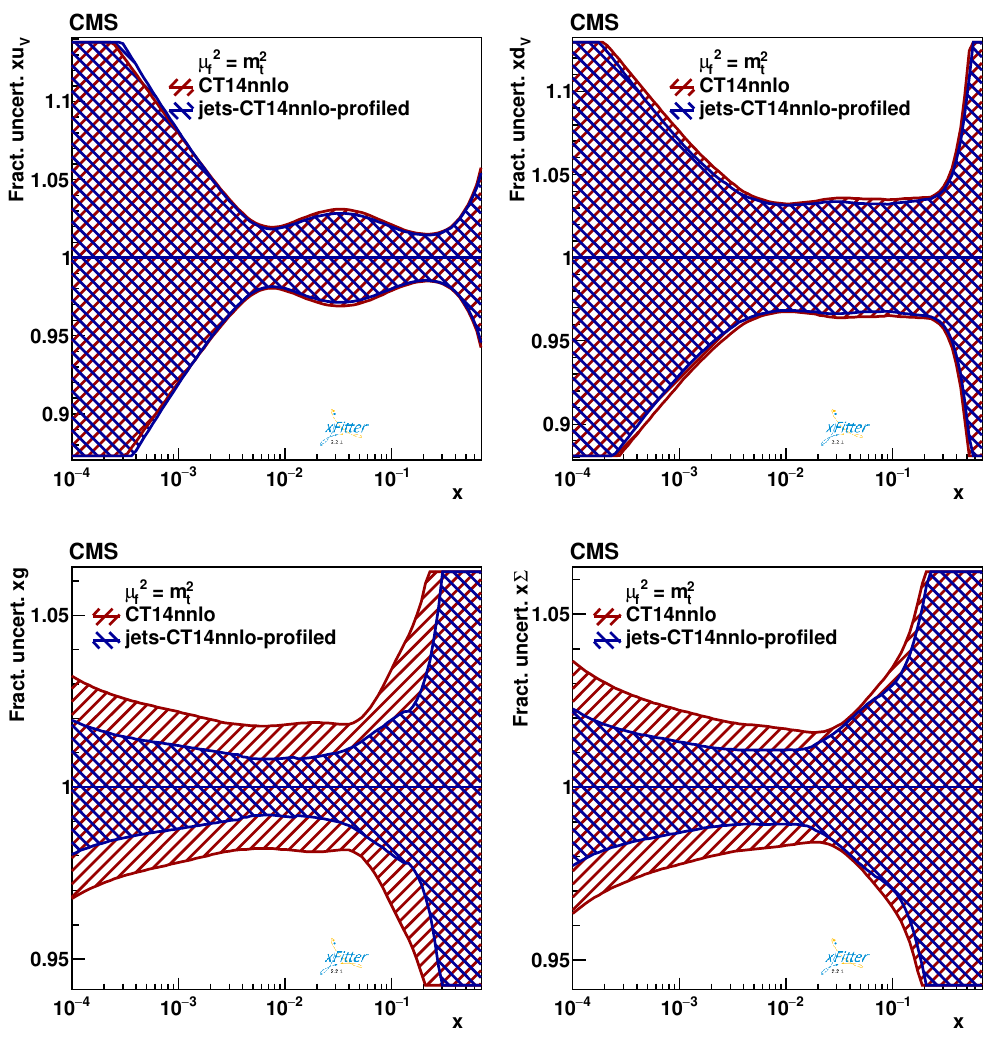
Figure 10 . Fractional uncertainties in the u -valence (upper left), d -valence (upper right), gluon (lower left), and the sea quark (lower right) distributions, shown as functions of x for the scale = m . The profiling is performed using CT14nnlo PDF at NNLO, by using the CMS inclusive µ f t √ jet cross section at s = 13 TeV, implying the theoretical prediction for these data at NNLO. The original uncertainty is shown in red, while the profiled result is shown in